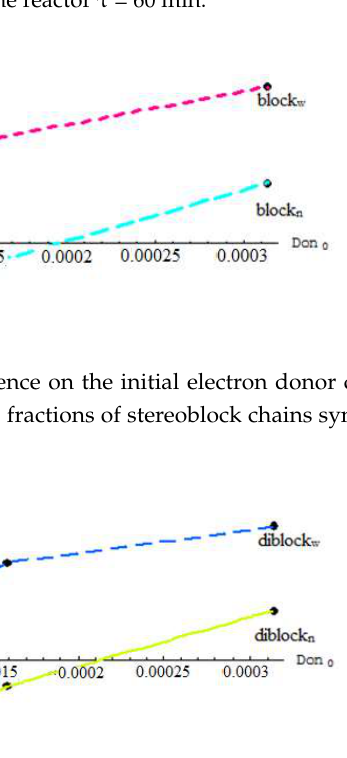
Figure 7. Dependence on the initial electron donor concentration of the average number Mn iso and the average weight Mw iso of the molecular masses of purely isotactic chains synthesized at the residence time in the reactor τ = 60 min.